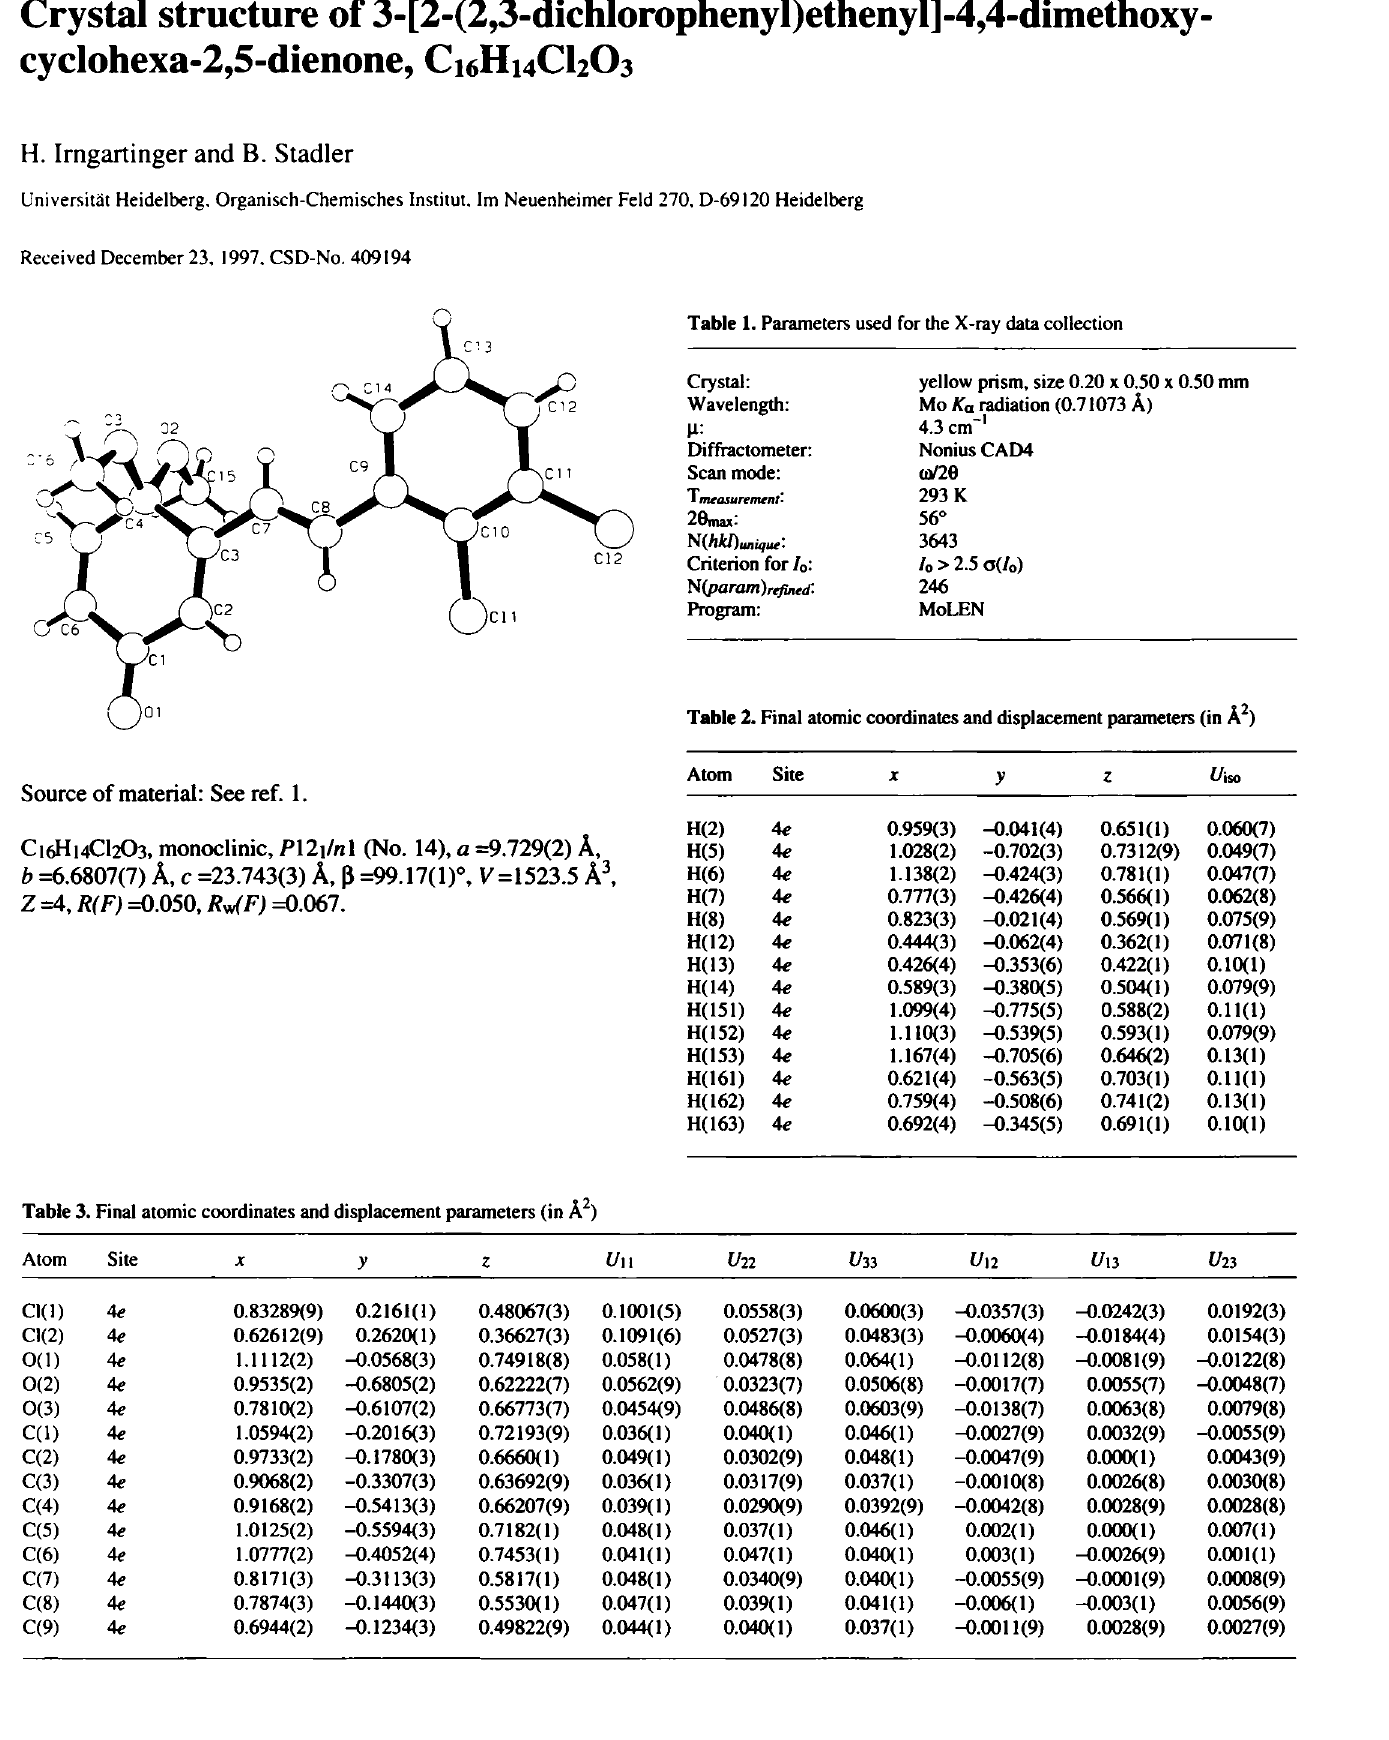
Table 1. Parameters used for the X-ray data collection